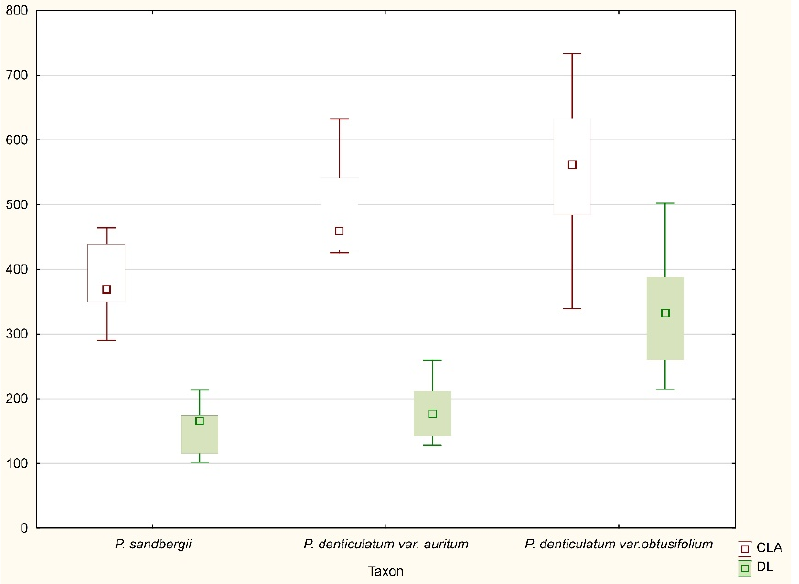
Figure 17. The range of variability of the examined features. Explanation: CL, average costae length; DL, decurrency length (length in μ m).